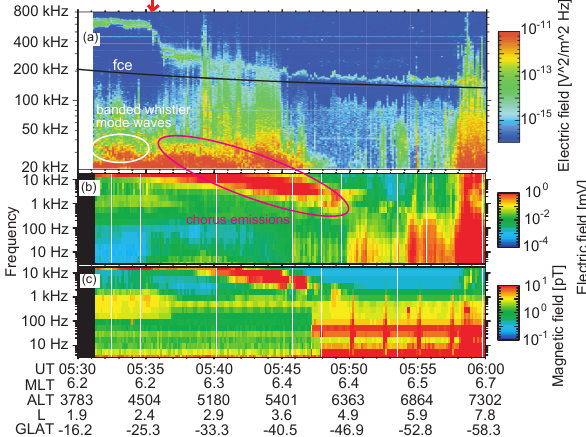
Fig. 4. Same as Fig. 3 but during the electron flux enhancement on day 308 of 1993. The red arrow shows the location of the plasma-